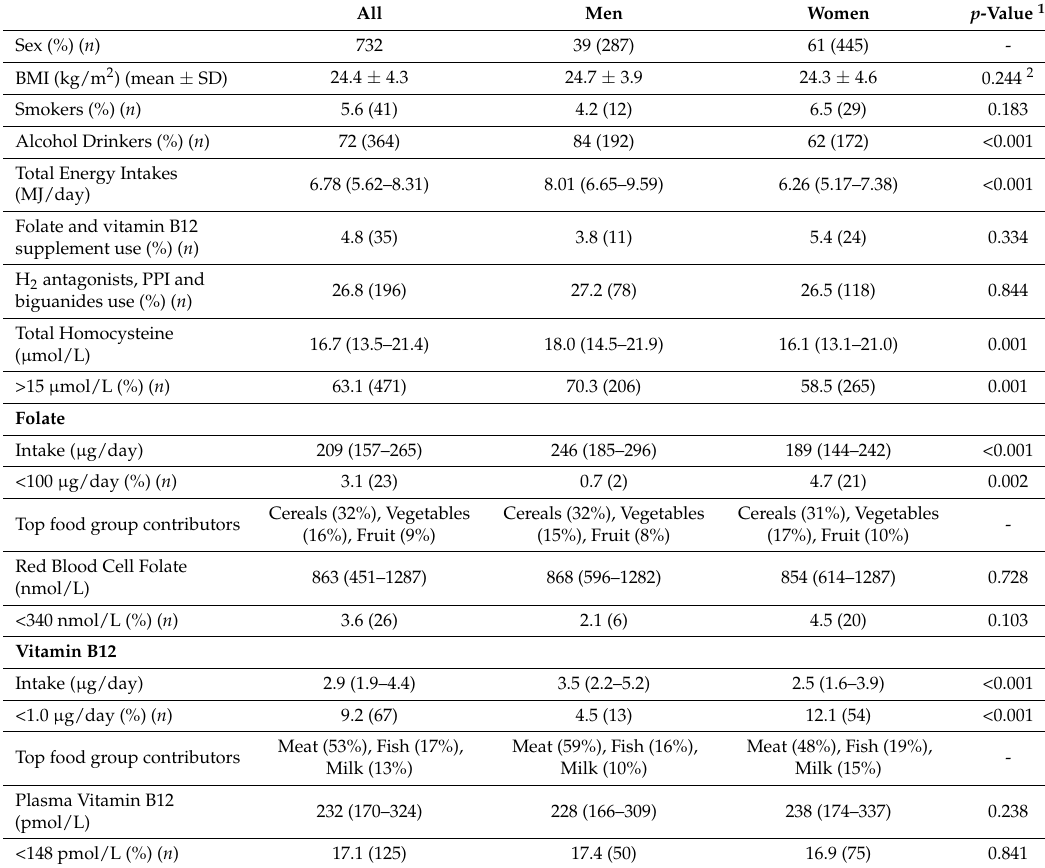
Table 1. Population characteristics, folate and vitamin B12 intakes and biomarkers of one carbon metabolism in the Newcastle 85+